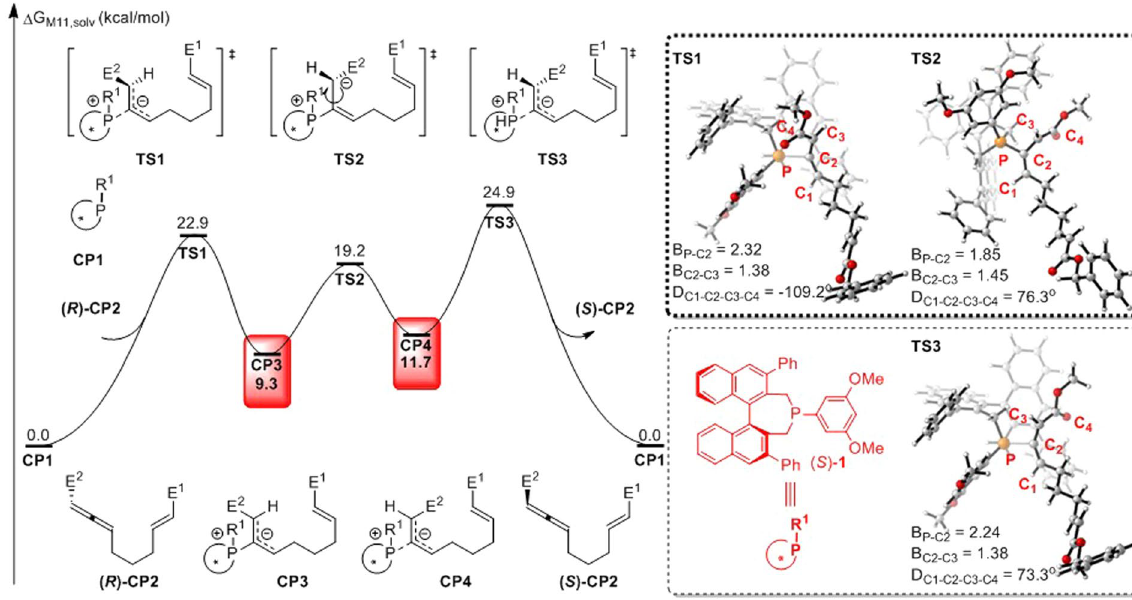
Figure 3. Free energy profiles for the nucleophilic addition step of binaphthophosphepine-catalyzed intramolecular [3 + 2] annulation (E 1 = CO 2 Bn, E 2 = CO 2 Me). Values are given by kcal/mol and represent the relative free energies calculated by M11 method in toluene solvent. The values in geometry information are given by angstrom.